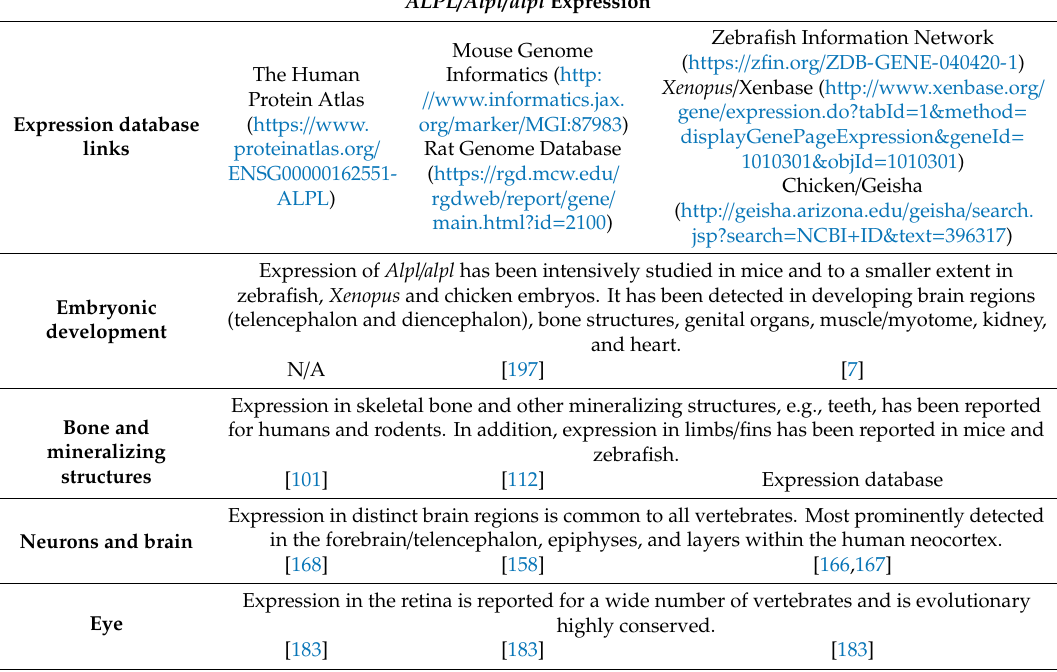
Table 1. Comparison of ALPL / Alpl / alpl expression and of TNAP / Tnap function in di ff erent species. Human Mouse and Rat Zebrafish and Other Vertebrates ALPL / Alpl / alpl